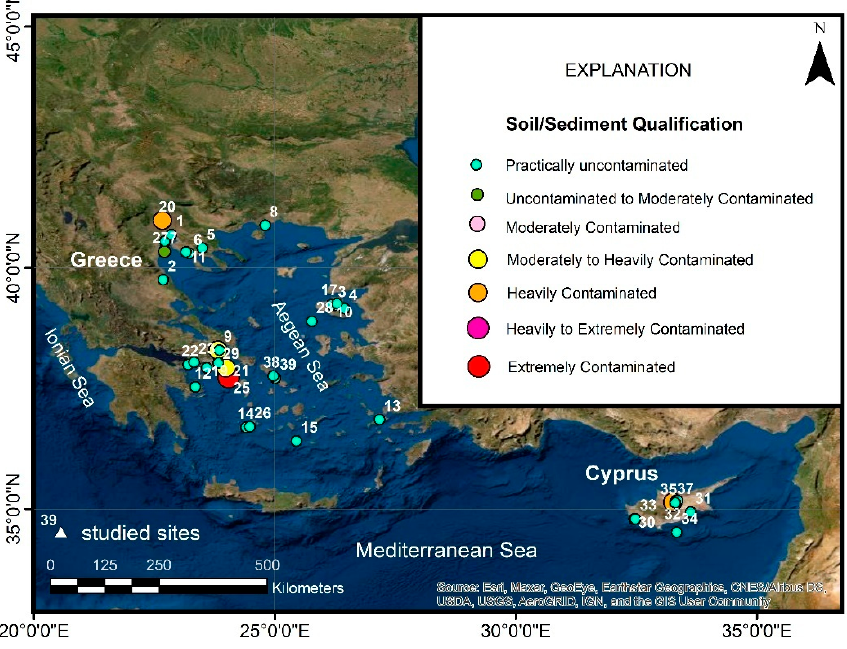
Figure 3. Spatial distribution of I geo classes for As in Greece and Cyprus (modified from [56]).